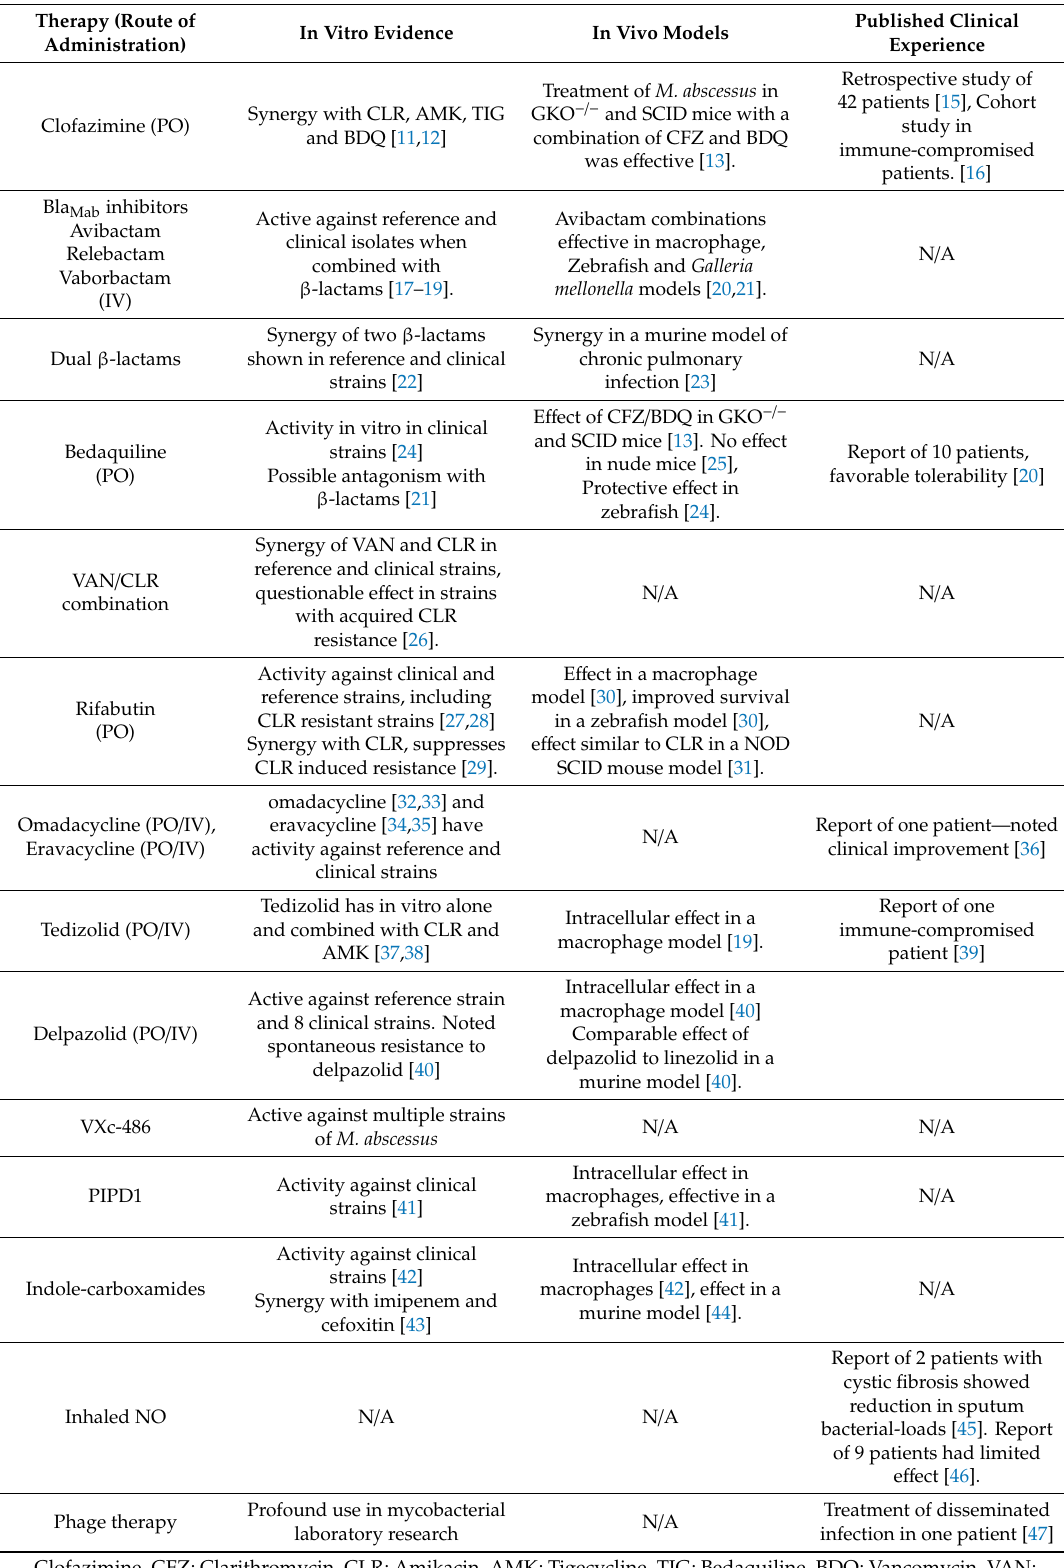
Table 1. Experimental therapies of Mycobacterium abscessus infections—evidence summary. Therapy (Route of